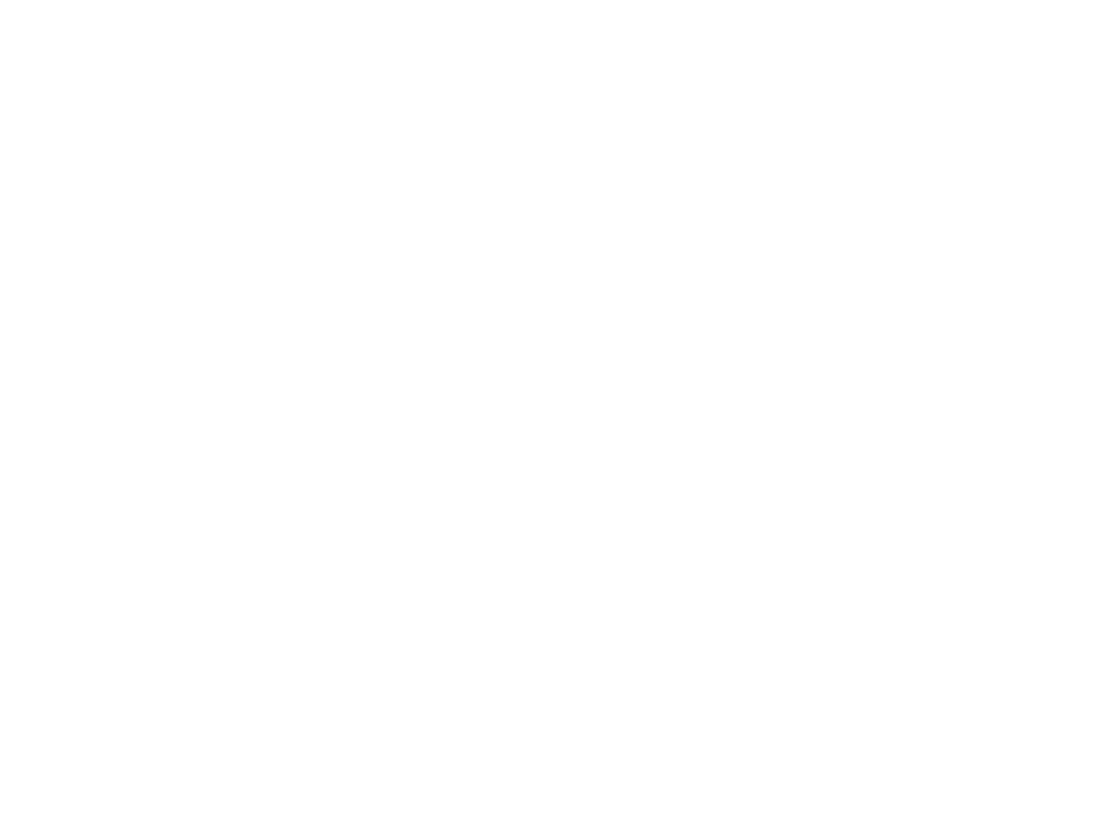
Frontiers in Forests and Global Change |